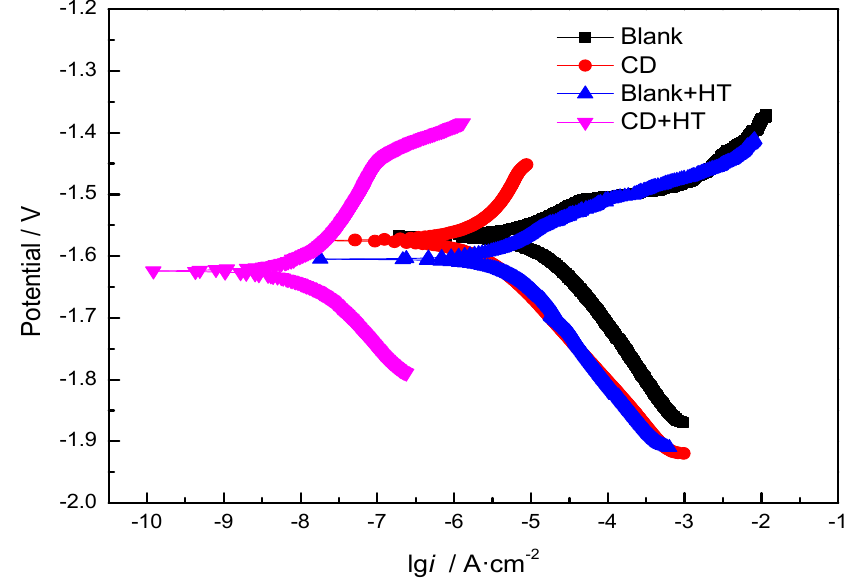
Figure 5. Potentiodynamic polarization (PDP) curves for typical samples in 3.5 wt % NaCl solutions. Table 3. Relevant electrochemical parameters from the polarization curves. Sample